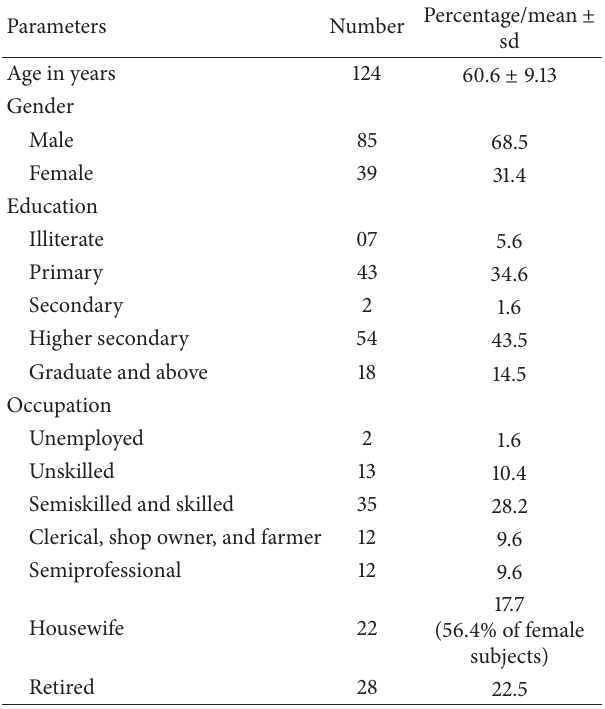
Table 1: Sociodemographic profile of the respondent diabetics ( 𝑛 = 124 ).